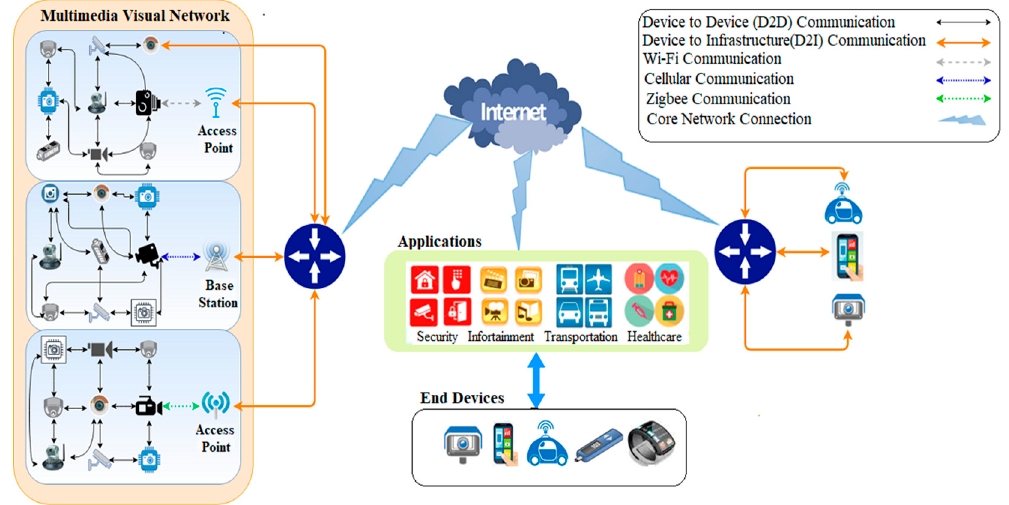
Figure 1. End-to-end communication over multimedia sensor networks in an Internet of Things (IoT).